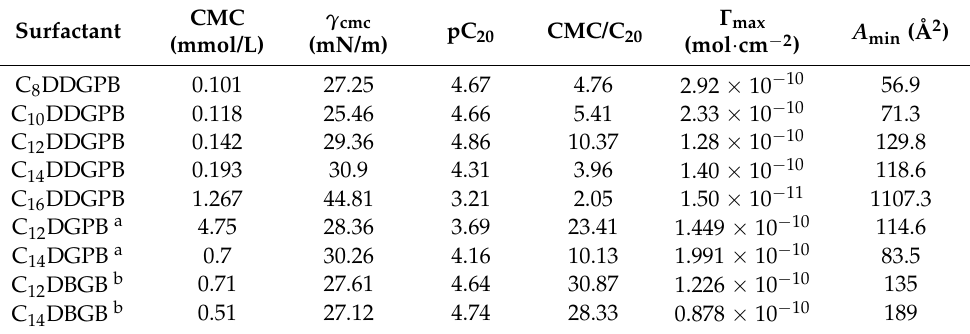
Table 1. Surfactant adsorption and aggregation parameters on the surface of an aqueous solution.